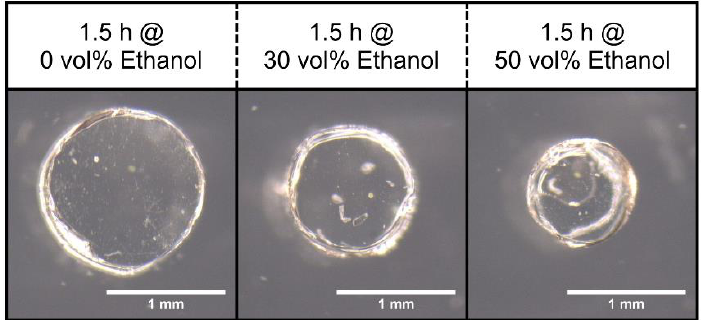
Figure 3. Swelling of a poly(acrylamide-bisacrylamide) hydrogel dot (diameter ca. 1.5 mm) in different ethanol–water mixtures.